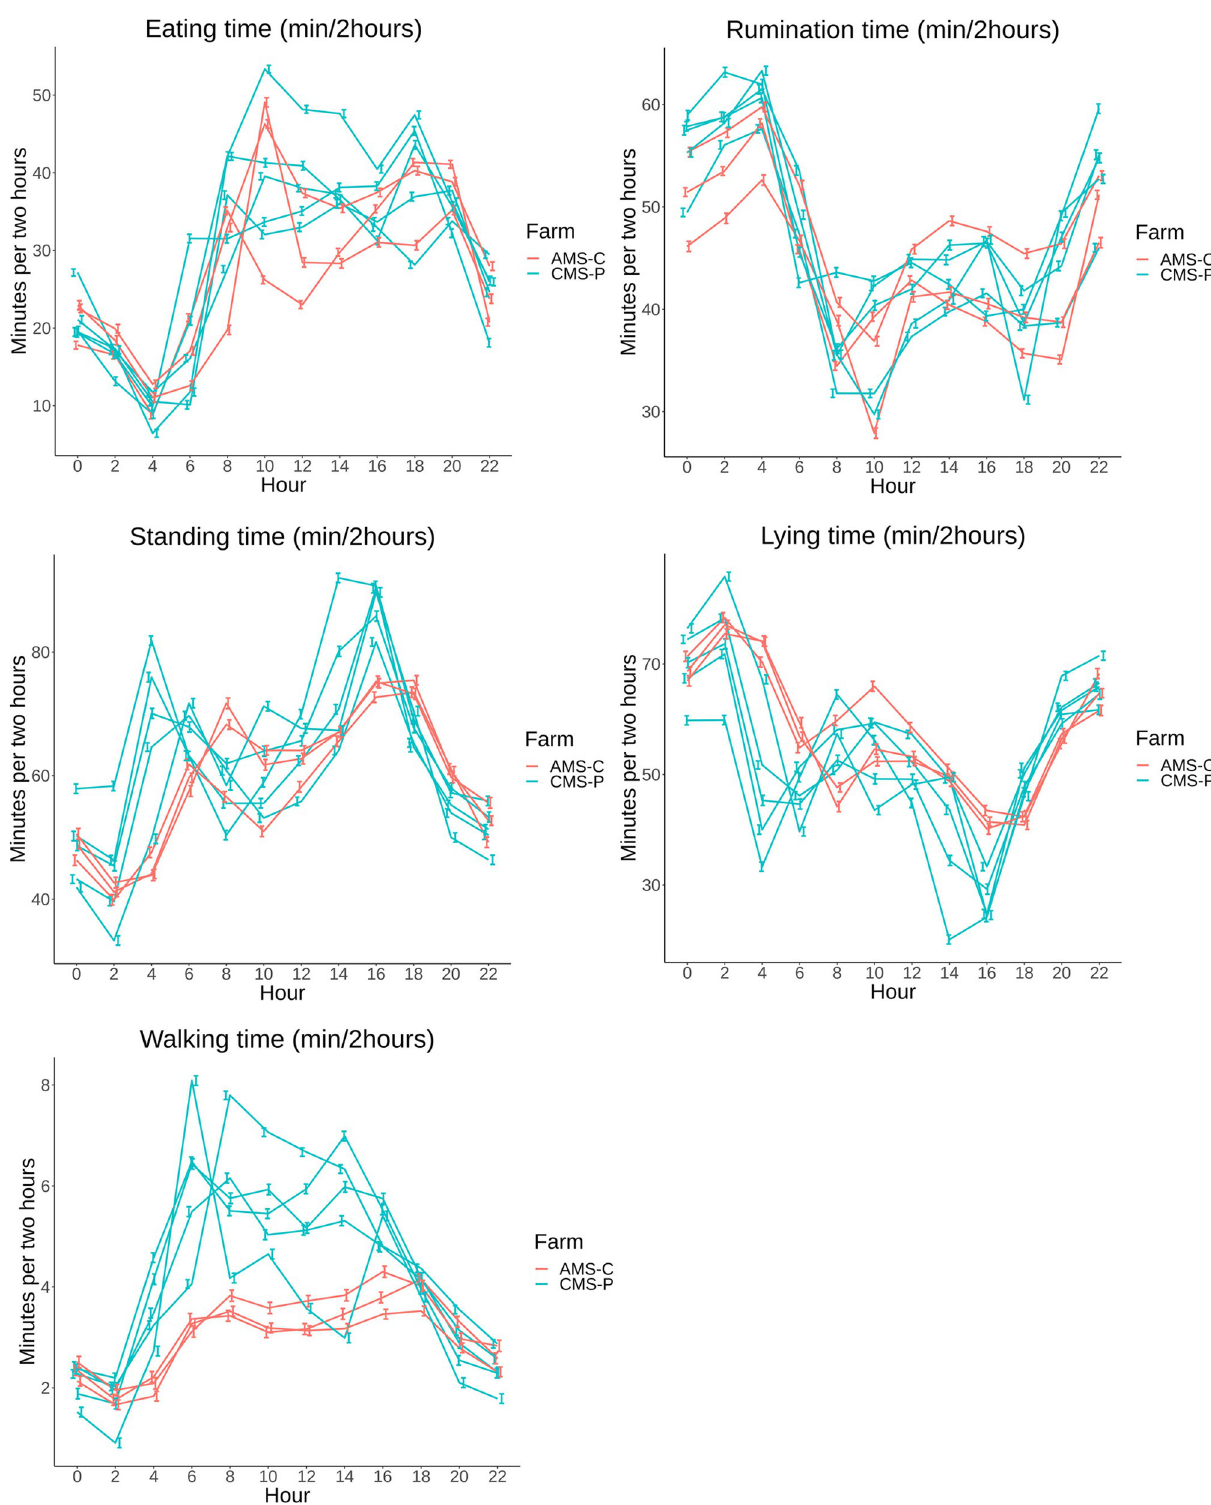
Fig 7. A,B,C,D,E: 24h pattern in minutes per 2 hours (min/2hours) based on least square means (LSM) with 95% confidence intervals (95% CI) per farm grouped by color: red = AMS-C, blue = CMS-P (automatic milking system–confined, and conventional milking system–pasture access) on 8 commercial dairy farms in The Netherlands from 00:00AM until 22:00PM.